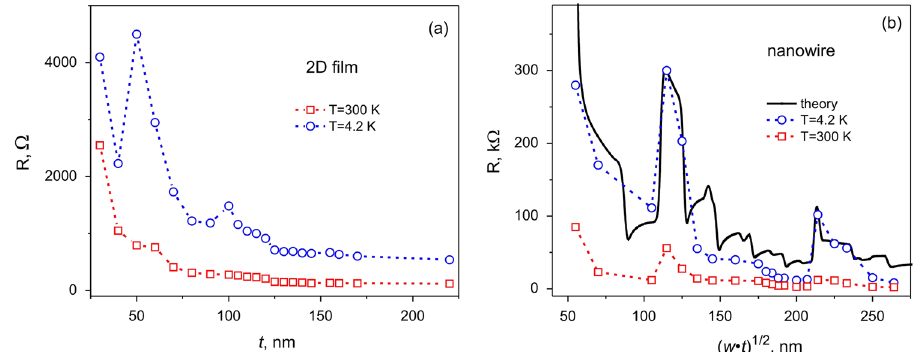
Fig. 3 Size dependence of resistance. a Typical dependence of co-deposited wide 2D bismuth fi lm resistance R on thickness t . b Dependence of bismuth nanowire resistance R on effective diameter d eff = ( w·t ) 1/2 . Circles ( ○ ) correspond to liquid helium temperature T = 4.2 K, squares ( □ ) stand for room temperature data. Dotted lines connecting experimental points are guides for eye. Theory fi t 15 ( solid line ) assumes rectangular wire with cross-section ( w·t ), the trigonal axis C3 being perpendicular to the sample plane and ~3 degree misorientation angle between the sample axis and the crystallographic bisectrix axis. Best fi t ‘ trajectory ’ in coordinates R(w,t) (see Fig. 2) stands for reduction of δ w = 1.87 nm and = 1.69 nm between successive points starting from a nanowire with initial width w = 300 nm and thickness t = 265 δ t